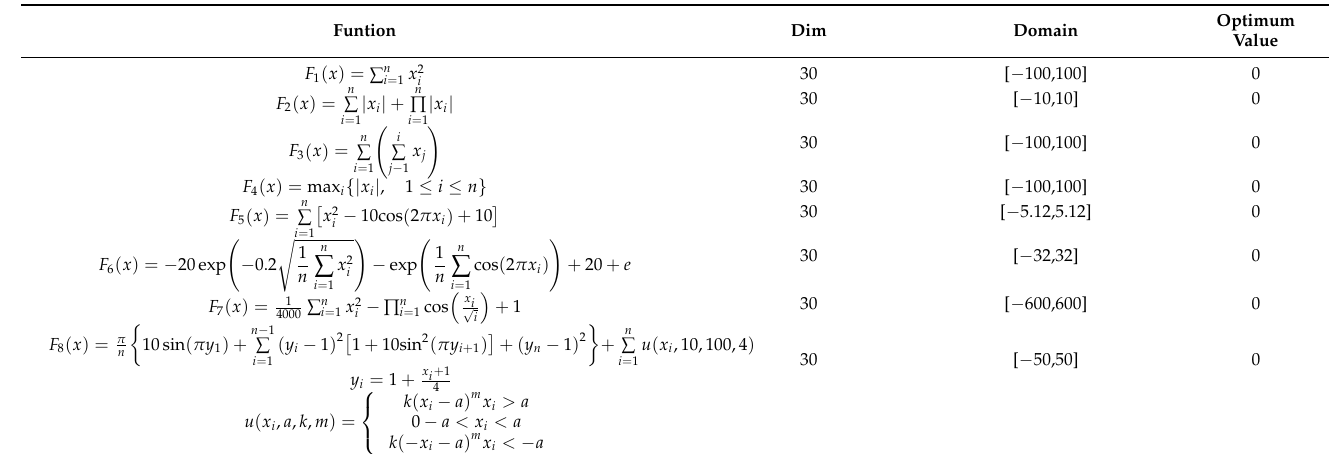
Table 1. Benchmark test